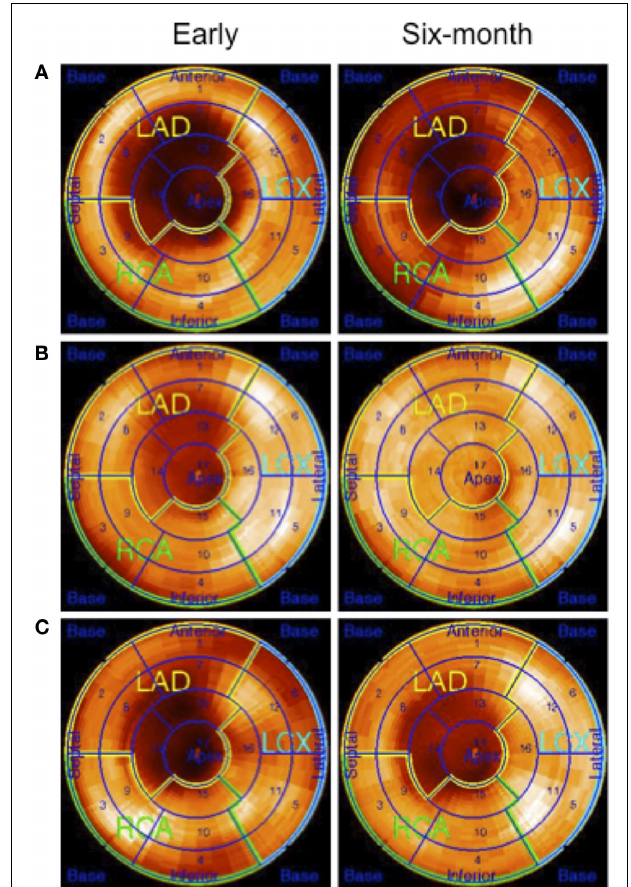
FIGURE 3 | Polar plots of [ 18 F]FDG-PET studies at 1–2weeks and 6months after placebo or BMC therapy. The patients are the same as in Figure 2 . (A) The patient with placebo treatment has a large defect in the LAD region.The defect size is slightly reduced (34–27%) at 6months, (B) a patient with BMC therapy has a moderate size defect in the LAD region at day 10–15 time-point, and the defect size was clearly reduced at 6months follow-up (21–2%), and (C) a patient with BMC therapy has a moderate size defect in the LAD region and no clear change in the defect size (26–22%) was observed at 6months